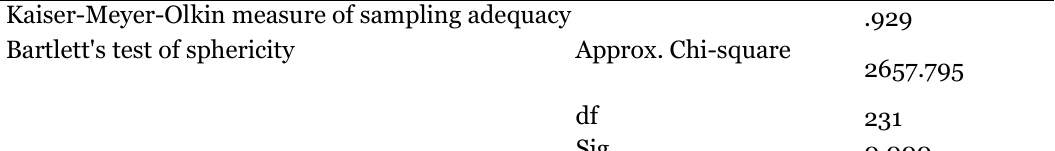
KMO Measure and Bartlett's Test Kaiser-Meyer-Olkin measure of sampling